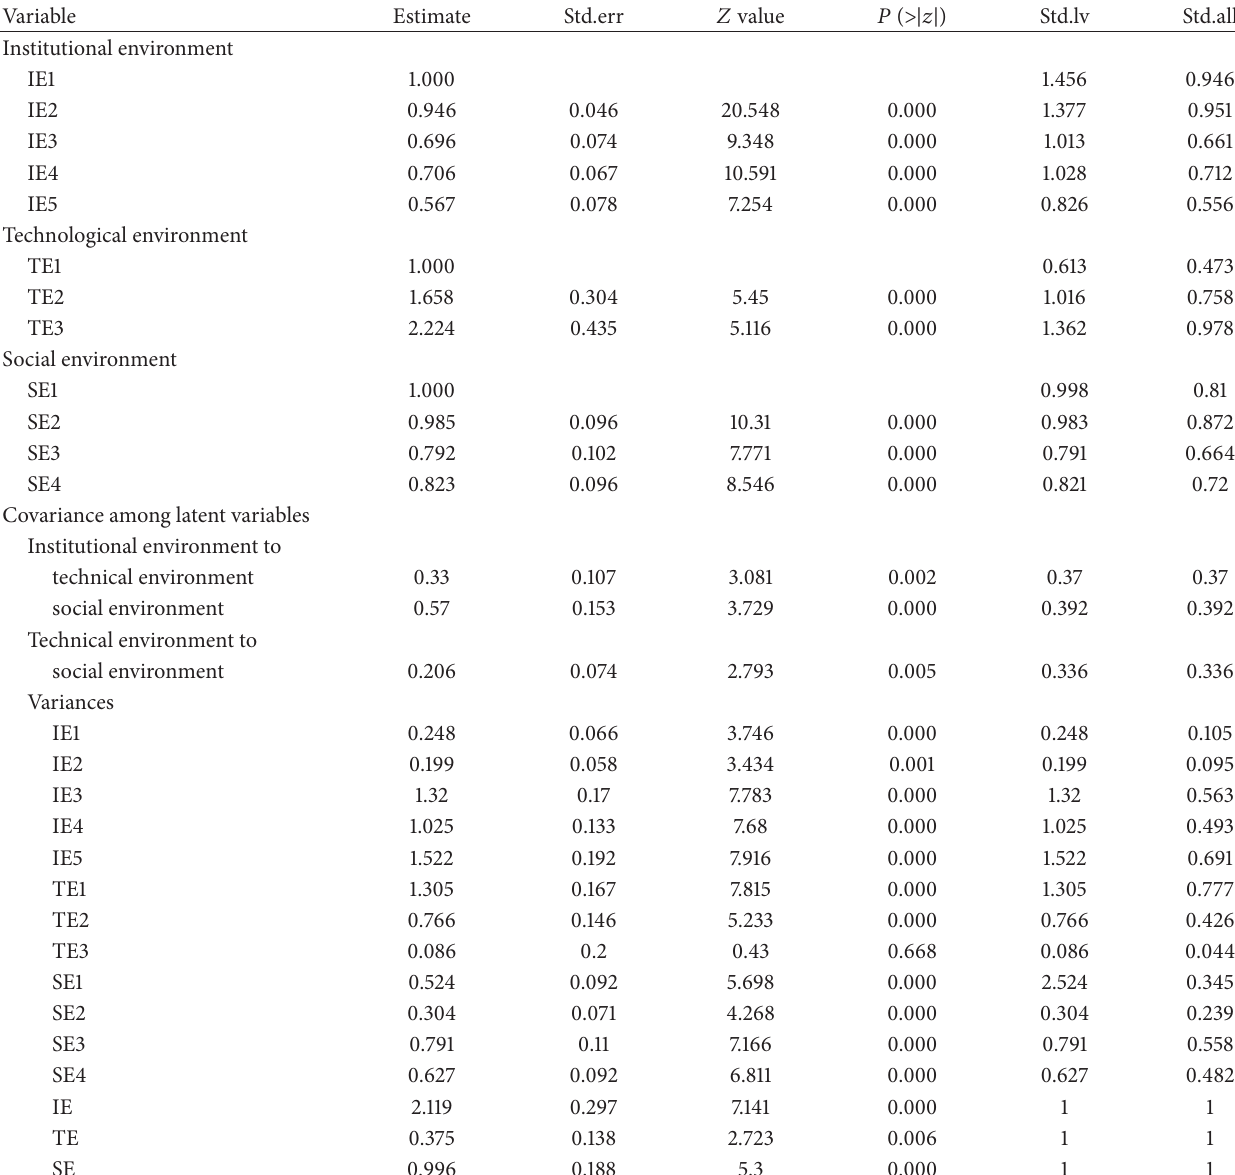
Table 2: Confirmatory factor analysis results for Ethiopia on institutional, technical, and social environmental variables relationship.